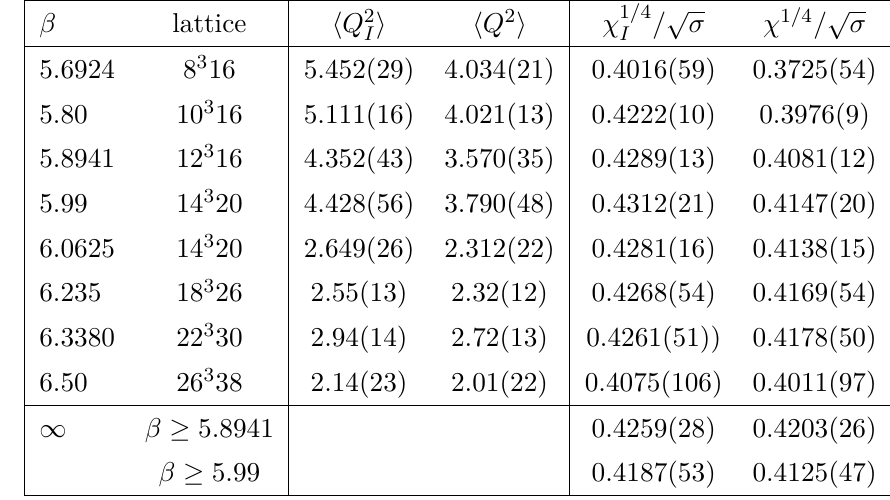
Table 22 . Fluctuations of the topological charge after 20 cooling sweeps. Q is the lattice value while Q I is the corresponding integer value. Also the corresponding susceptibilities in units of the string tension, and their continuum limits where the fits cover the range of β indicated.